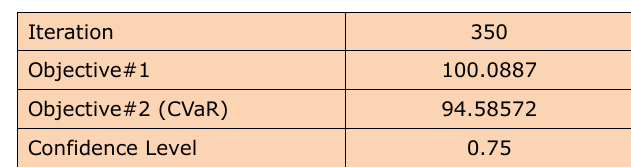
Table 19. Objective’s values and confidence level of NSGA-II for the proposed test problem